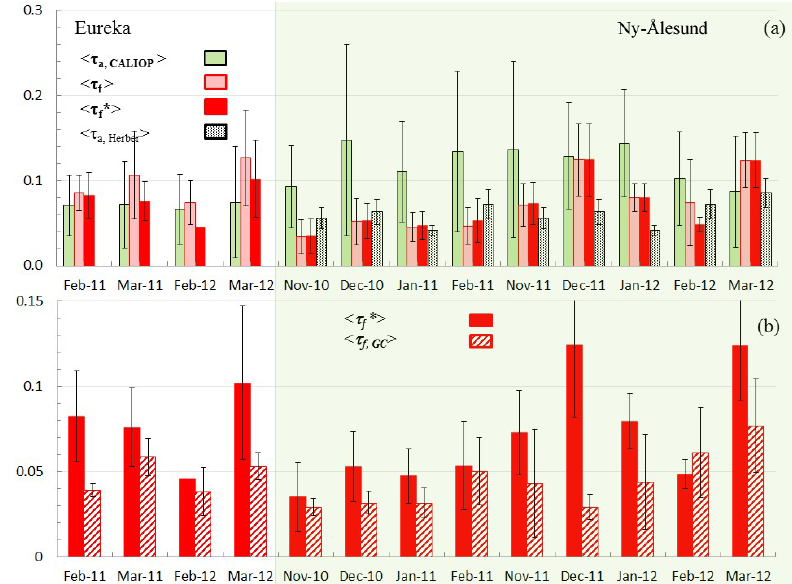
> , and the 9-year AOD climatology of Herber et al. (2002). For our purposes we simply Figure 4. (a) < τ a , CALIOP > , < τ f > , < τ ∗ f > values of (a) compared with < τ f , GC > repeated Herber’s values that belonged to the same calendar month. (b) Zoom of the < τ ∗ f